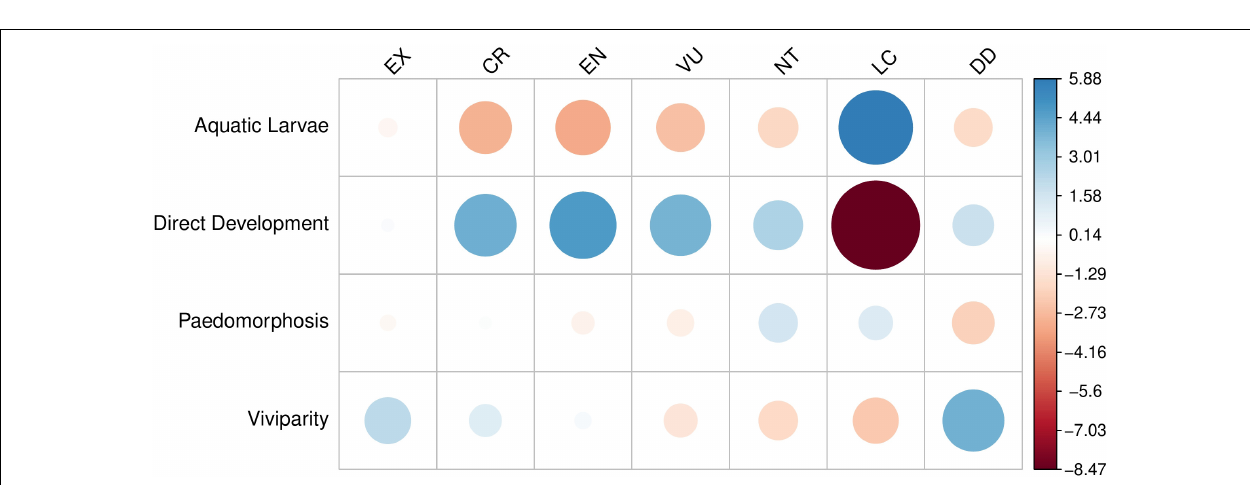
FIGURE 4 | IUCN Red List status of all amphibians by major life-history strategies. The height of each bar corresponds to the percentage of the group in each Red List status category (EX, extinct; CR, critically endangered; EN, endangered; VU, vulnerable; NT, near threatened; LC, least concern; DD, data deficient).